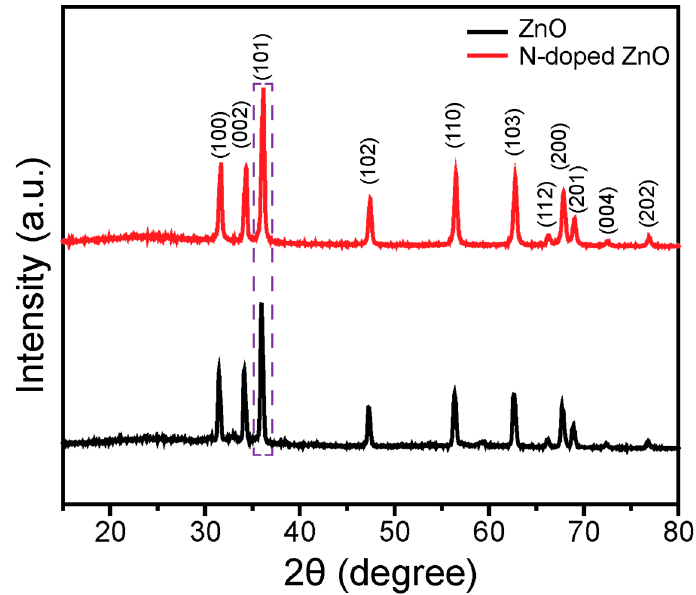
Figure 1. XRD patterns of the ZnO and N-doped